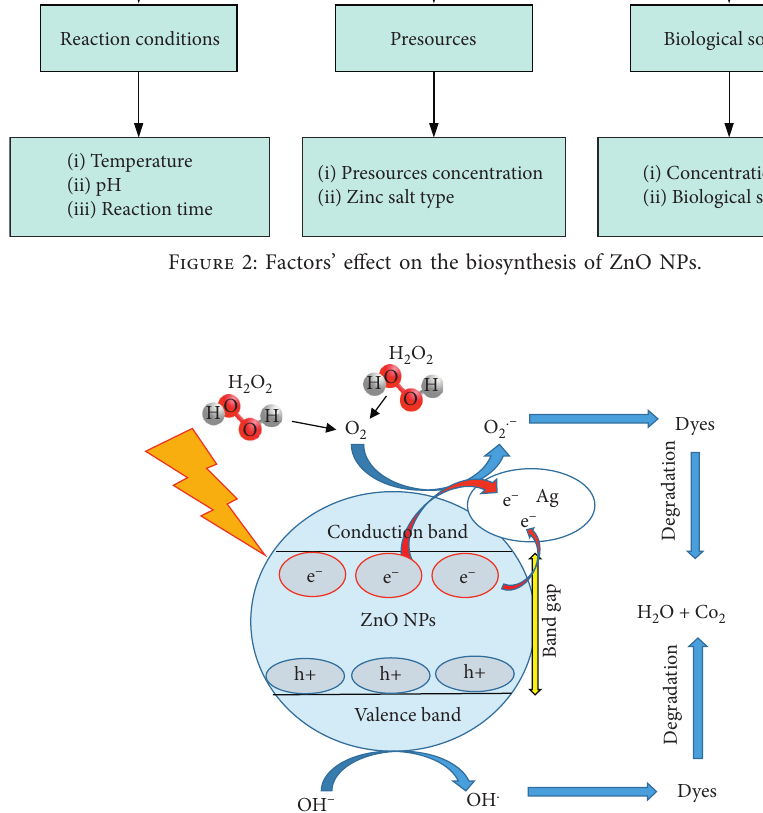
Figure 3: The proposed photocatalytic mechanism of ZnO